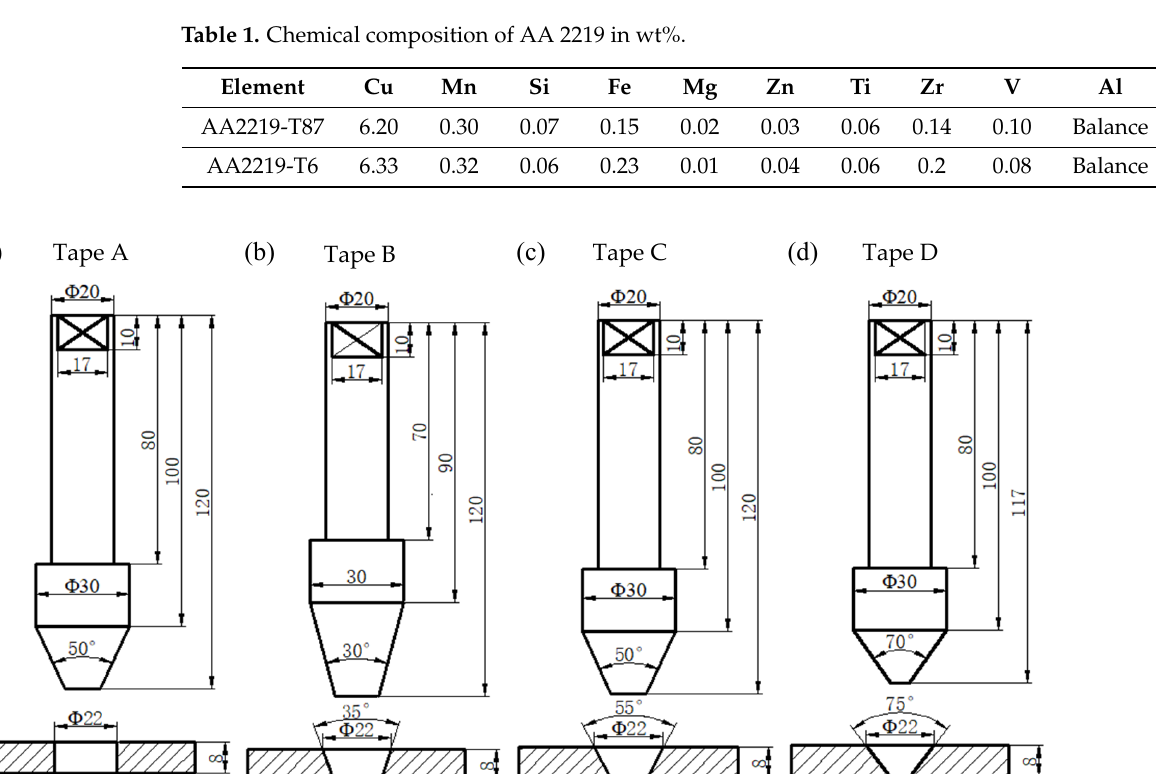
Figure 1. Geometric dimensions of plug and plate hole (mm) : ( a ) 30° plug and straight plate hole, ( b ) 30° plug and 35° plate hole, ( c ) 50° plug and 55° plate hole and ( d ) 70° plug and 75° plate hole.